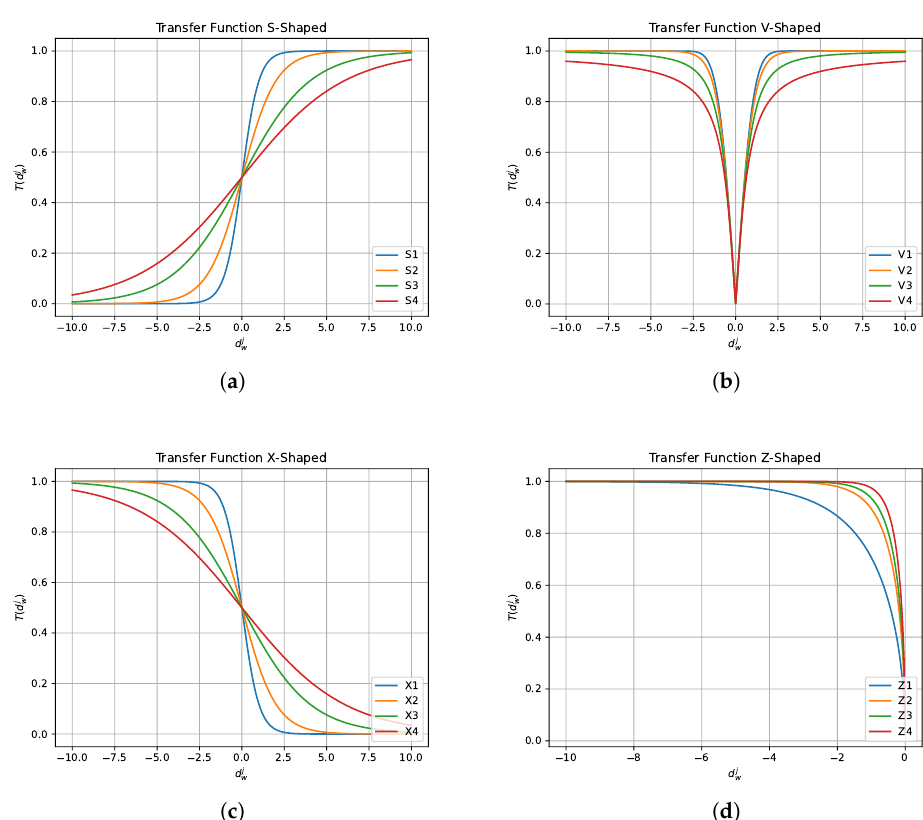
Figure 4. Transfer functions. ( a ) S-shaped; ( b ) V-shaped; ( c ) X-shaped; ( d )